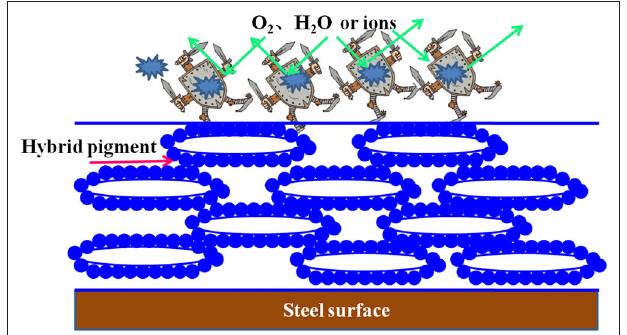
Frontiers in Chemistry |